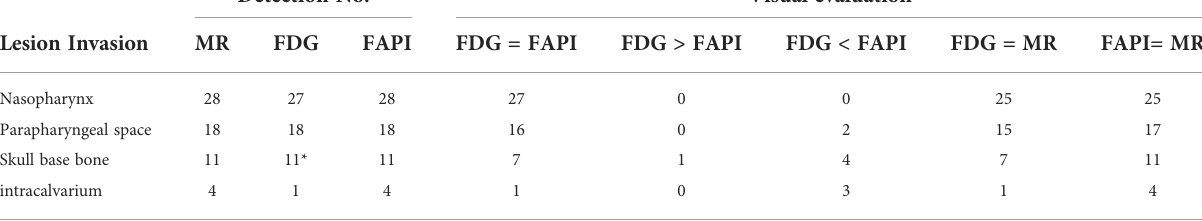
TABLE 3 Visual evaluation of tumor invasion using the 3 modalities. Detection No.